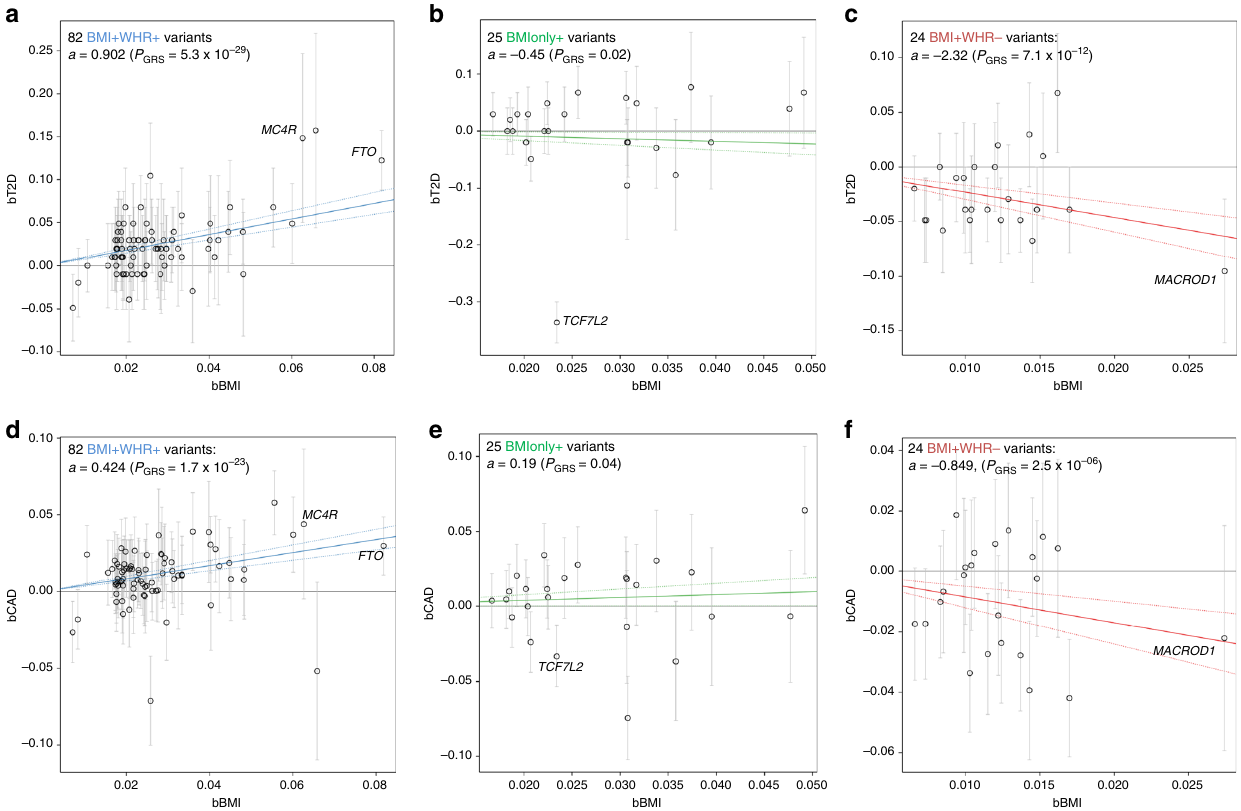
Fig. 5 Different disease implications. Shown are the class-speci fi c variants ’ co-associations for BMI and T2D or CAD (from DIAGRAM 15 and CARDIoGRAMplusC4D 18 ) and the meta-regression line that can be interpreted as the association of the genetic risk score of BMI-increasing alleles (GRS) and disease (slope estimate indicated as “ a ” , p value as P GRS ): a BMI + WHR + variants on T2D, b BMIonly + variants on T2D; c BMI + WHR − variants on T2D; d BMI + WHR + variants on CAD, e BMIonly + variants on CAD; f BMI + WHR − variants on CAD. Although the higher GRS for BMI is signi fi cantly associated with increased T2D and CAD risk for BMI + WHR + variants, it is associated with decreased T2D and CAD risk for BMI + WHR −